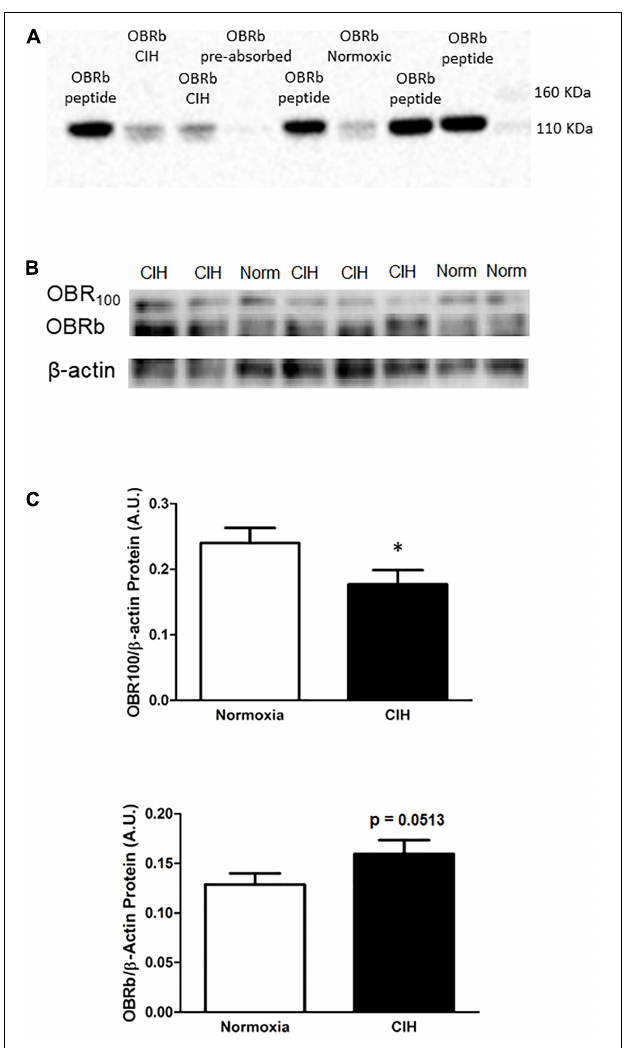
FIGURE 6 | (A) Is a representative western blot depicting OBRb/ β -actin protein expression in the ARC following exposure to CIH or normoxia, and negative control following pre-absorption of the primary antibody with the corresponding immunizing peptide. Note that the absorption of the antibody (CH14104; Neuromics) with the LepRB/Orb control protein (P14014; Neuromics) did not result in the labeling of the OBRb protein in the ARC. (B,C) Representative Western blots (B) and bar graphs (C) depicting OBR100/ β -actin and OBRb/ β -actin protein expression in the ARC following CIH exposure. Note that leptin receptor isoform (OBR 100 ) thought to be involved in transporting leptin across the blood brain barrier is reduced, whereas the OBRb isoform does not change although there is a trend toward an increase following CIH exposure. Data are shown as mean ± standard error. n = 10 per group. * p <